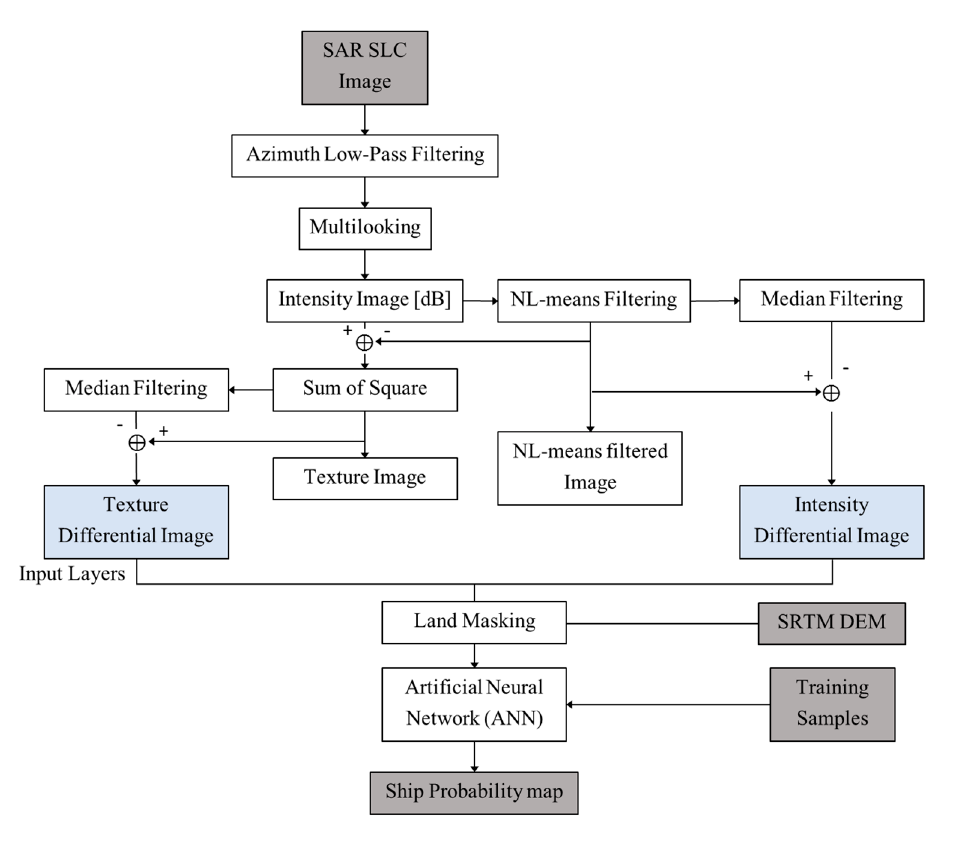
Figure 2. Detailed workflow of the proposed method in this study. SAR: synthetic aperture radar; SRTM DEM: shuttle radar topography mission digital elevation model; NL: non-local.